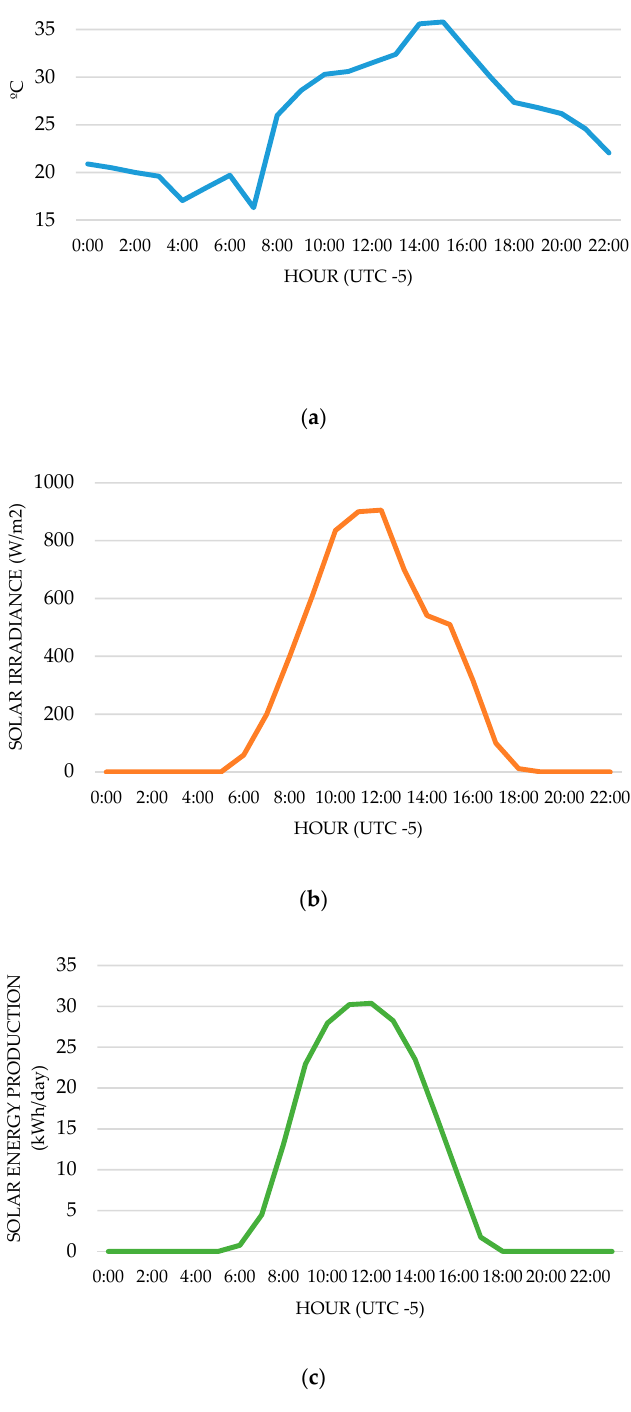
Figure 8. ( a ) Ambient temperature, ( b ) solar irradiance and ( c ) energy generated by the PV system on 3 August (time in hours corresponding to UTC-5).